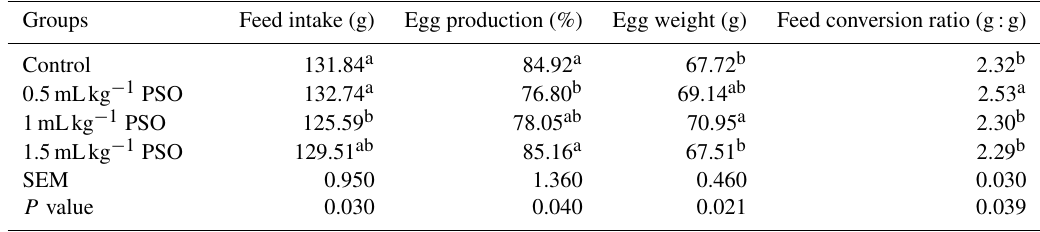
Table 3. Effect of pomagranate seed oil on performance in laying